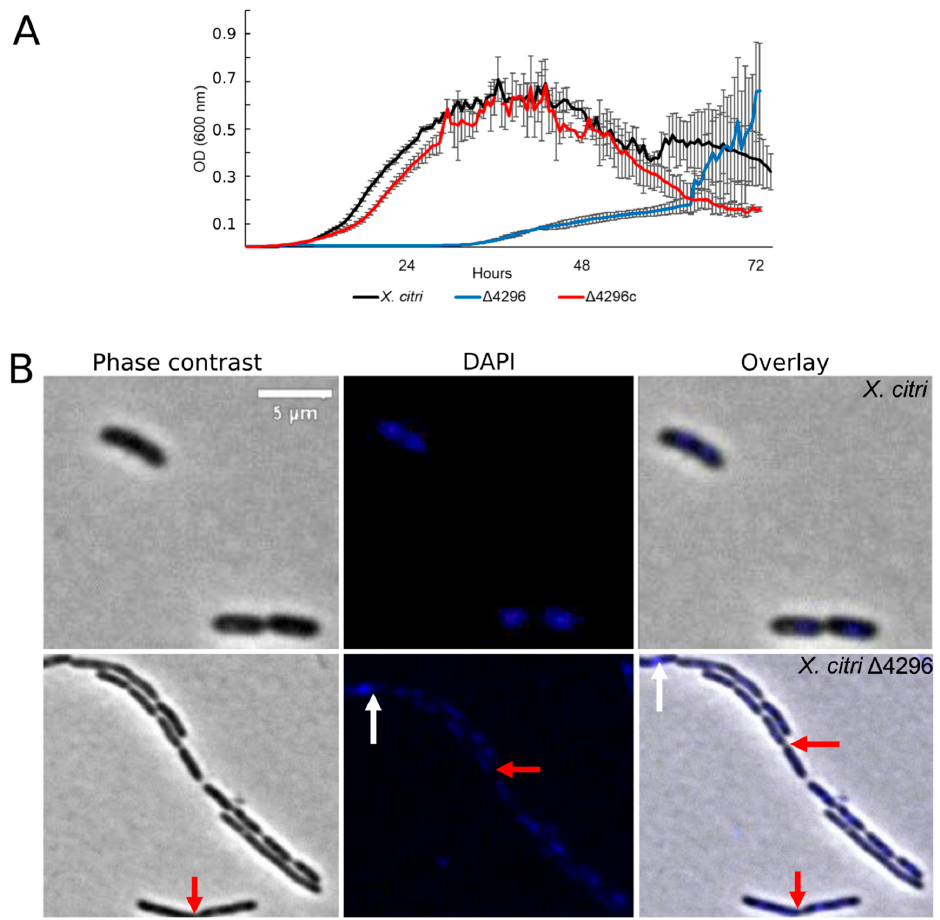
Figure 4. XAC4296 may be related to β -lactam antibiotic resistance in X. citri ( A ) Ex planta bacteri- al growth curves performed on rich medium and ampicillin 20 µg/mL for X. citri , Δ 4296, and Δ 4296c. Δ 4296 growth is affected in the presence of ampicillin. Error bars indicate the standard er- ror of three independent biological and technical replicates. ( B ) Morphological analysis and er- rors/aberrant nucleoid distribution of X. citri , Δ 4296, and Δ 4296c strains of X. citri and Δ 4296 strains on NB supplemented with ampicillin 20 µg/mL. All cultures of mutant Δ 4296 exhibit short filaments and chain phenotype. The figure shows the phase contrast, DAPI, and overlay of the two images for X. citri and Δ 4296 (magnification of 100×). White arrows indicate the chromosome posi- tion, and red arrows indicate septum constriction (magnification of 100×)—scale = 5 µm.